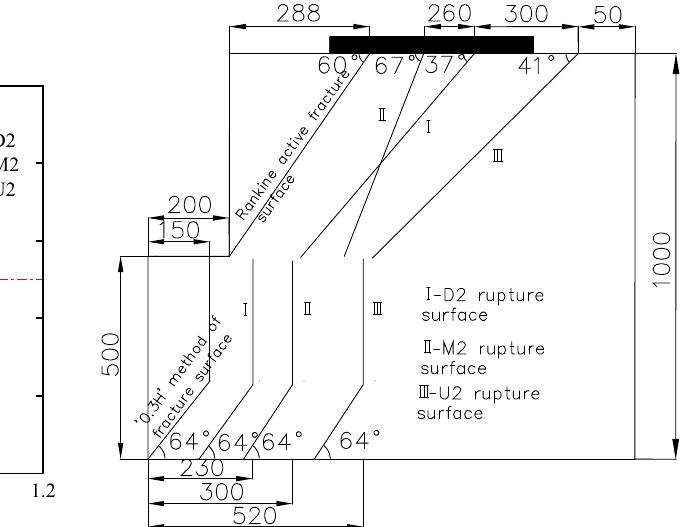
Figure 10: Position of the peak strain point of reinforcement.